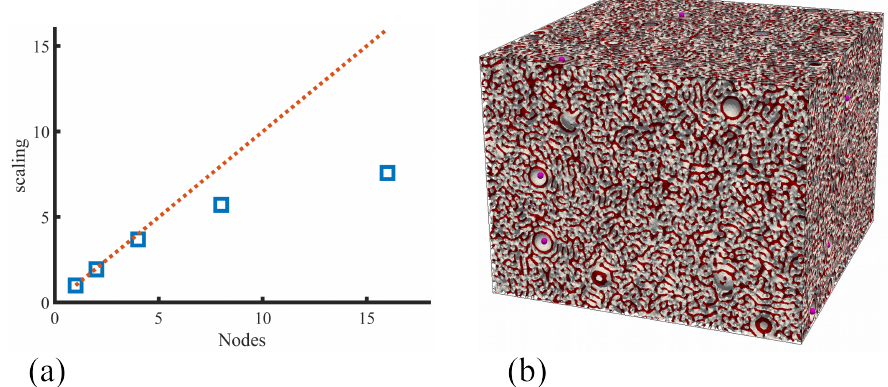
Figure 7. Performance of the parallel hybrid algorithm. In ( a ), strong scaling is shown for a system with N p = 10 4 particles in a V = 256 3 box system, using 8 processors in the CSCS supercomputer. In ( b ), a snapshot of a relatively large system with V = 400 2 × 300 with N p = 100 particles with radius R ef f = 13.3 is shown. Reprinted with permission from Ref. [175] Copyright 2021